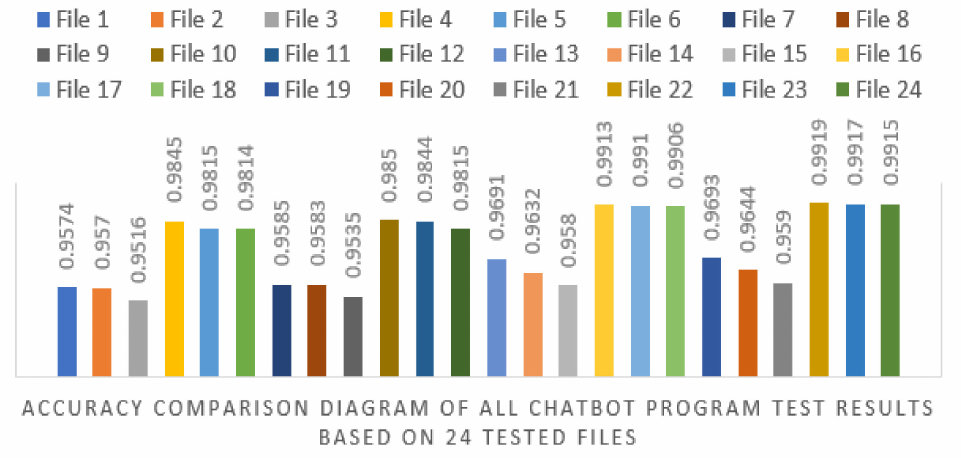
Figure 5. Accuracy comparison diagram of all chatbot program test results based on 24 tested